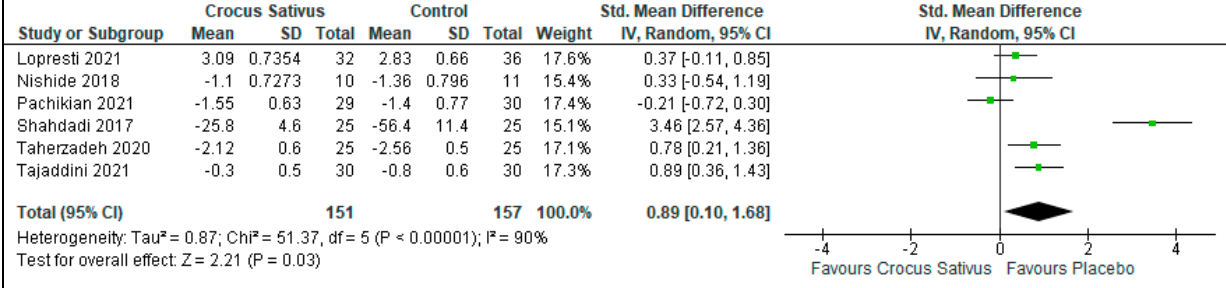
Figure 5. Forest plot for the outcome sleep quality [25–30]. Note: Line indicates confidence interval and the green square indicates effect estimate. Black diamond indicates cumulative effect estimate and its confidence interval.